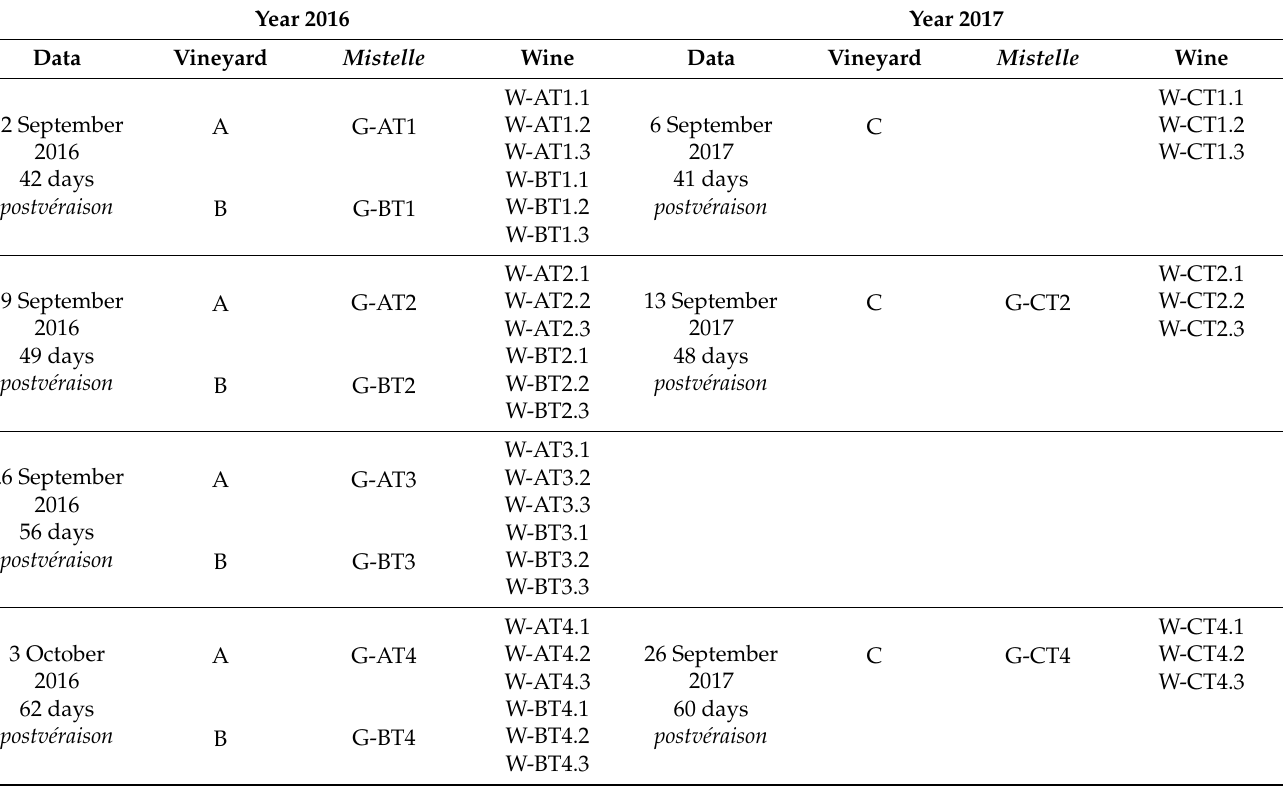
Table 1. Samples Table. Micro-vinifications and mistelles made with Moristel grapes with different degrees of maturation from plots with different features. The first letter of each abbreviation refers to the samples (G = mistelles and W = wine). The second letter is the vineyard (A, B or C); Tx is